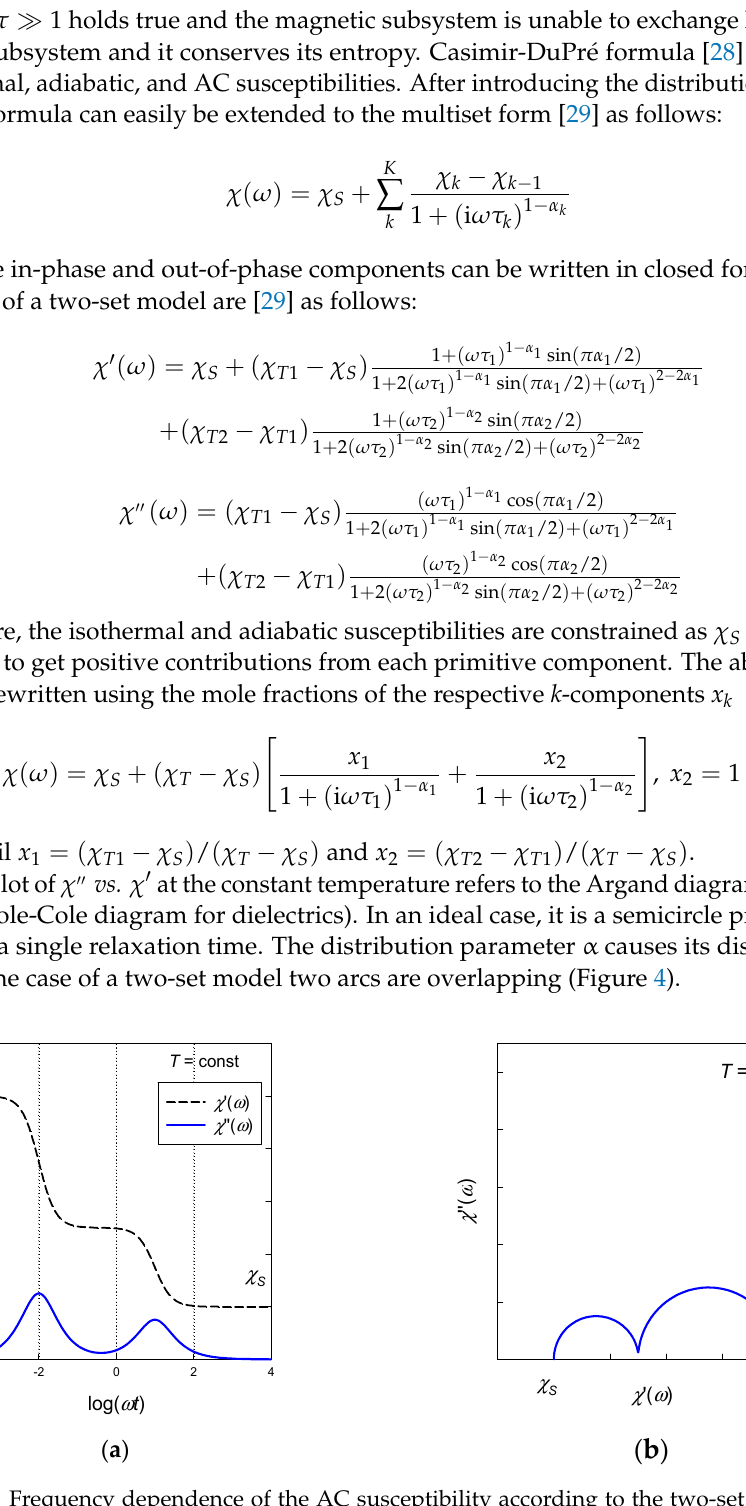
Figure 4. Frequency dependence of the AC susceptibility according to the two-set Debye model. ( a ) Envelope of AC susceptibility components. ( b ) Ideal Argand diagram ( α 1 = α 2 = 0) with two overlapping semicircles.